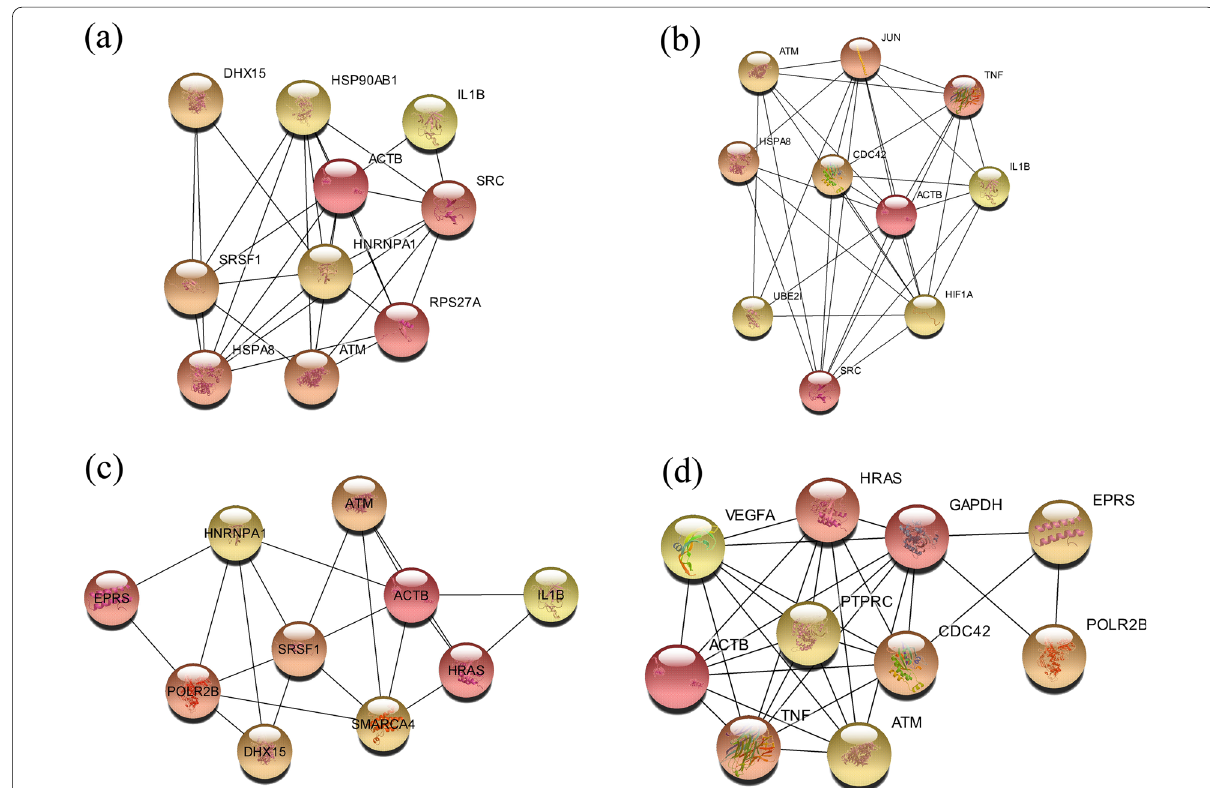
Fig. 5 Correlation between the identified DEGs and immune cell infiltration (TIMER); p value < 0.05 represented statistically